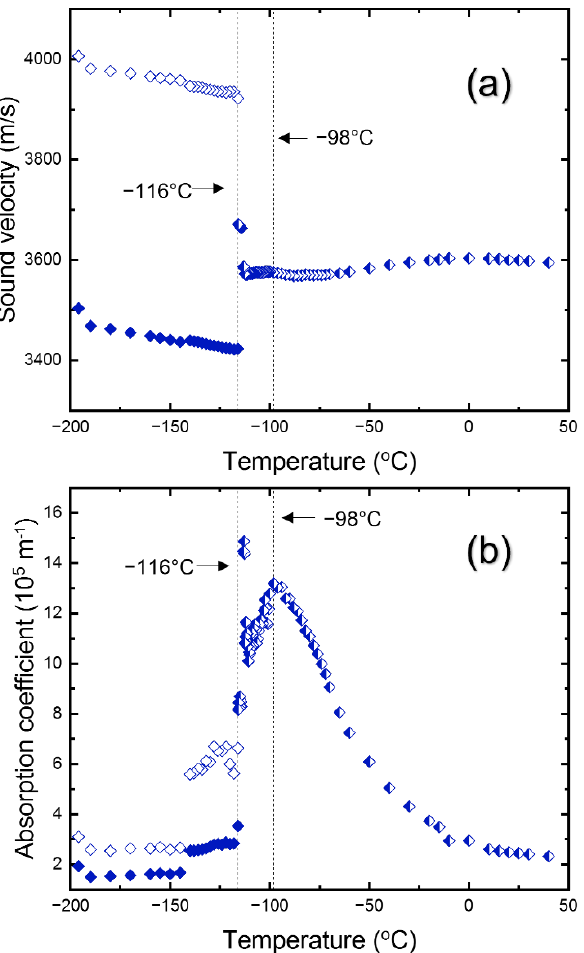
Figure 5. (Color online). Temperature dependences of ( a ) the sound velocity and ( b ) the absorption coefficient of the LA mode. Phase boundaries are shown as vertical dotted lines along with the phase transition temperatures. The two symbols at low temperatures indicate the data from the split LA mode.